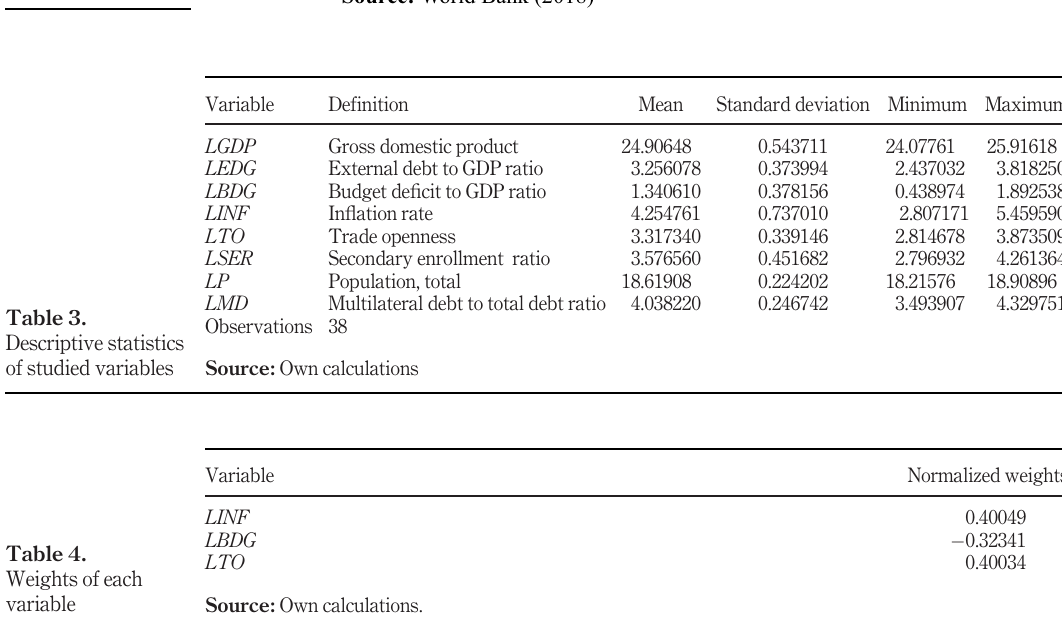
Figure 4. Relationship between EDG ratio and growth in Bangladesh